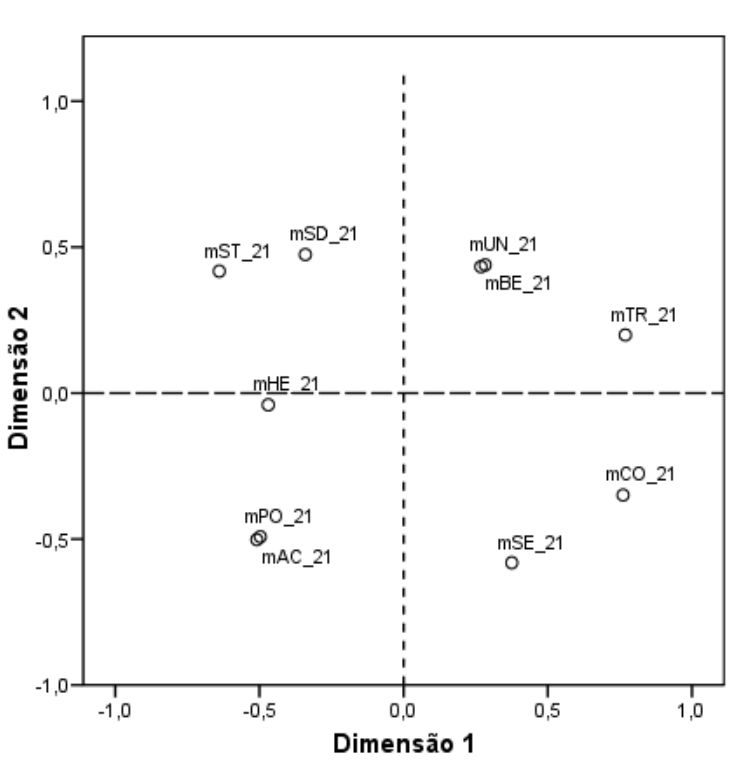
Figura 7. WCMDS por tipo motivacional –